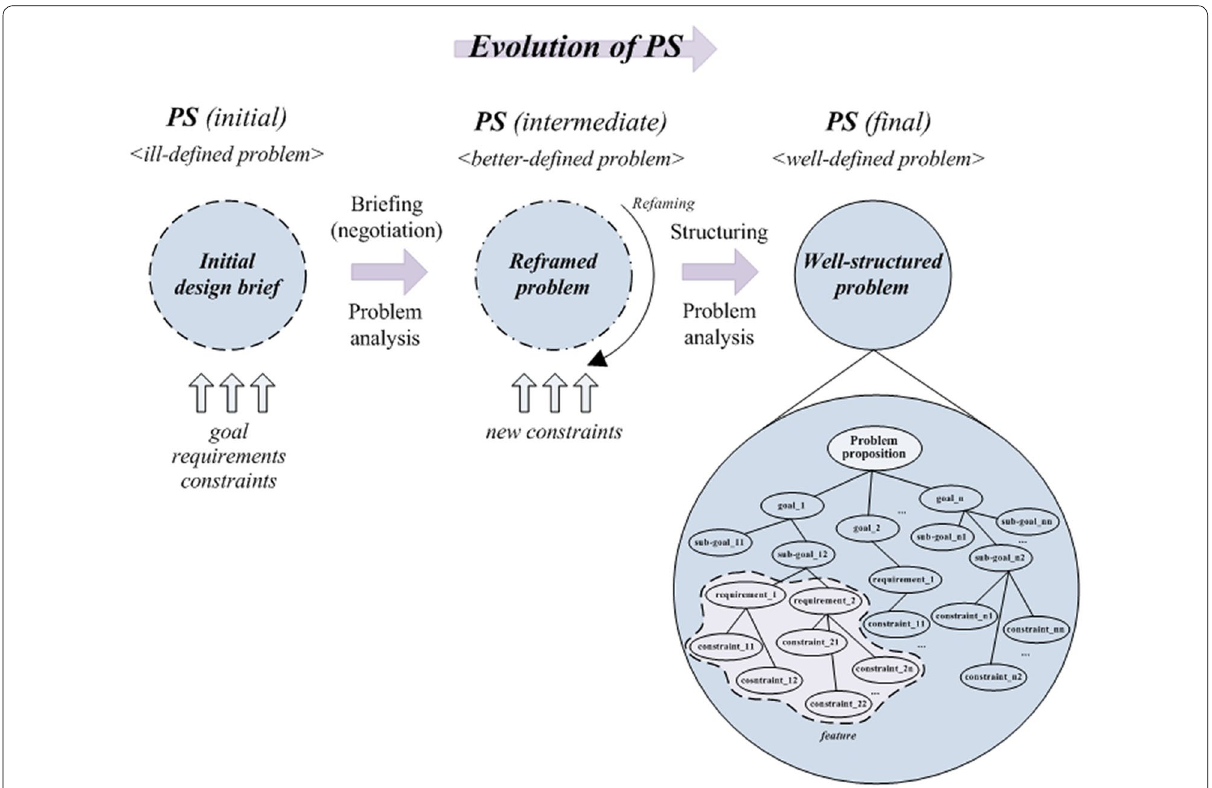
Figure 6 Evolution of the problem